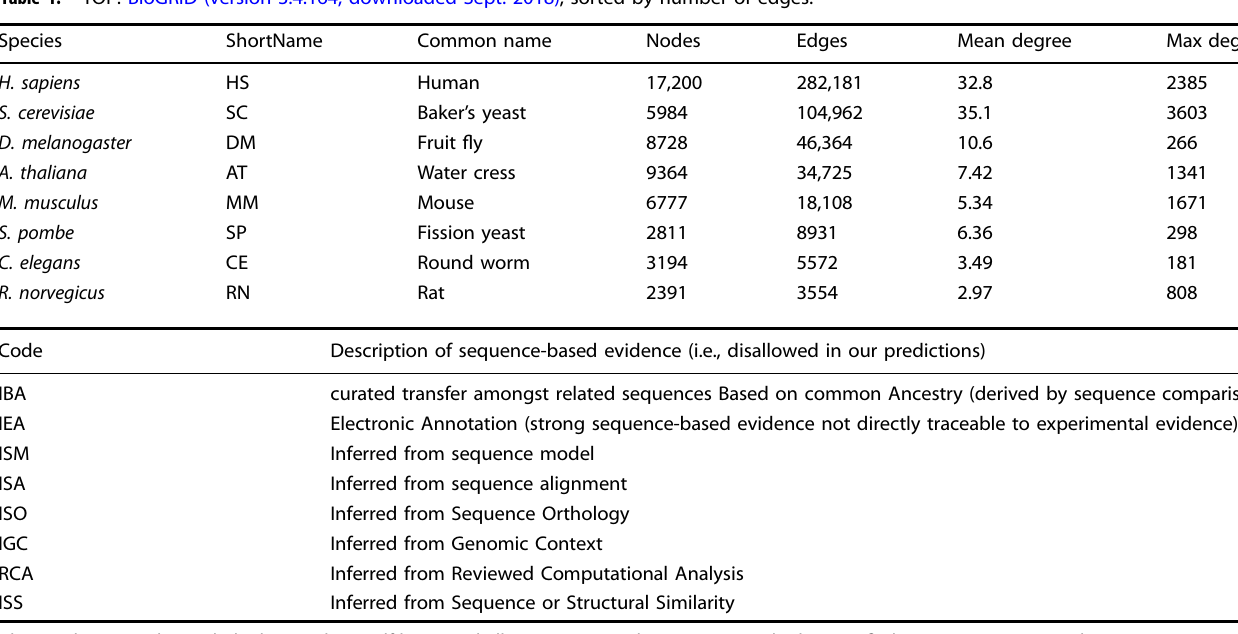
The graphs are undirected; duplicate edges, self-loops and all interactions with proteins outside the speci fi ed species were removed. BOTTOM: Sequence-based GO evidence codes disallowed in “ NOSEQ ” cases: Note that we are rather more Draconian in our interpretation of “ sequence- based ” than is the norm: we disallow any code in which sequence could have had any in fl uence, including manually curated sequence comparison. This supports our hypothesis that NAF discovers semantic similarity “ in the absence of sequence similarity ” .